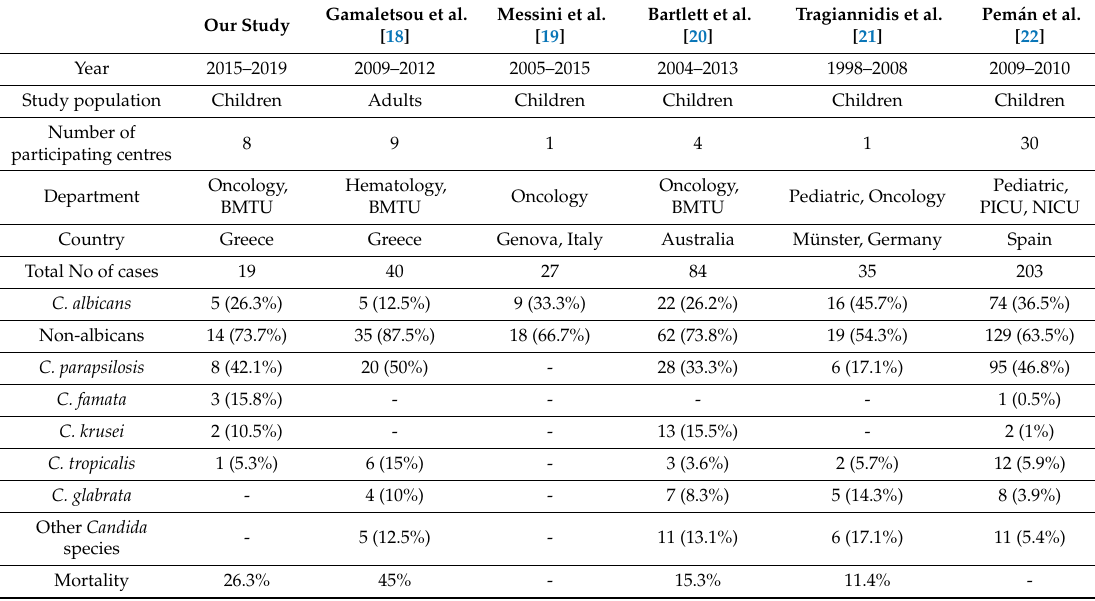
Table 4. Comparative table of Candida epidemiology